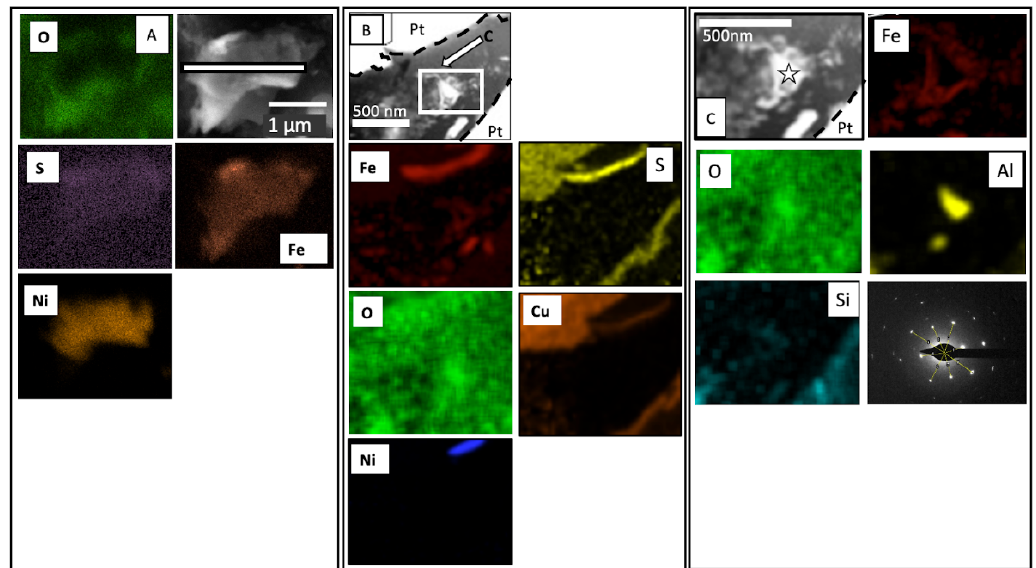
Figure 5. ( A ) SEM image and EDS element maps of a representative colloid soils developing on historic coal mine spoil; the white line represents the site of FIB section extraction. ( B ) TEM image of the extracted FIB section with EDS element maps; the dashed black line represents the boundary between the FIB section and the Pt mount, and the white box labeled C is shown in panel ( C ). ( C ) TEM image, EDS element maps, and electron diffraction image collected at the starred location; the grain was identified as muscovite based on the ( − 1,1,4) reflection with a d ‐ spacing of 3.4954 Å.